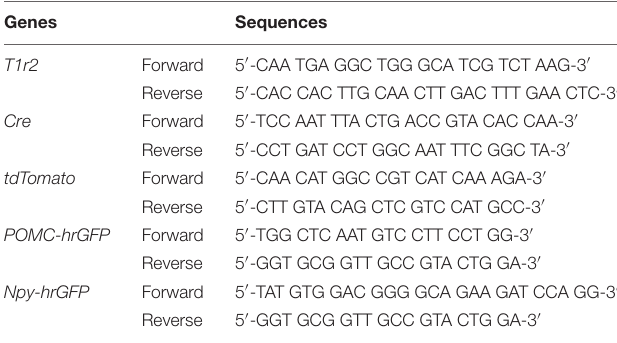
TABLE 1 | Primer sequences used for